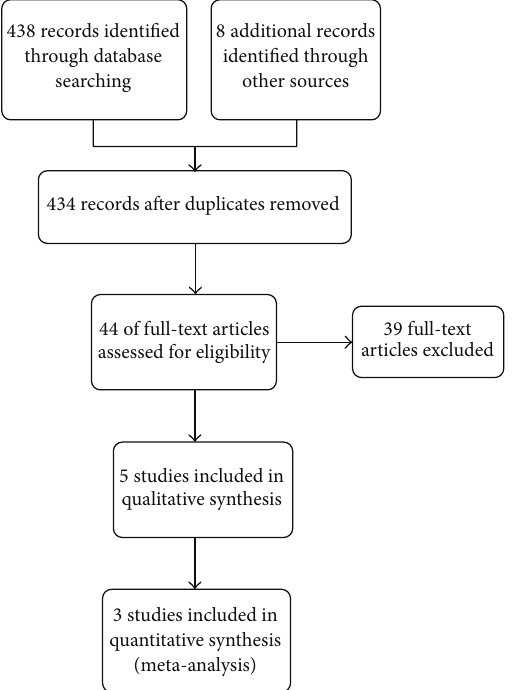
Figure 1: The PRISMA flow diagram of study selection